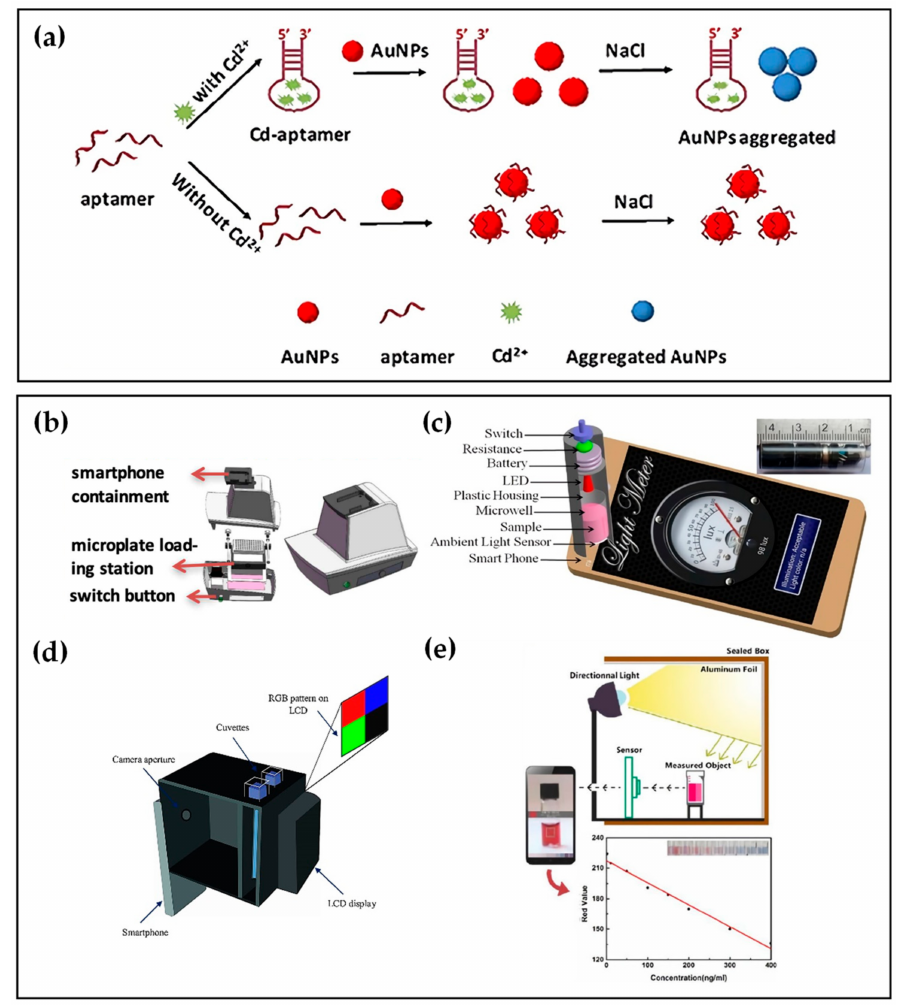
Figure 1. ( a ) Colorimetric detection principle based on AuNPs. Reprinted with permission